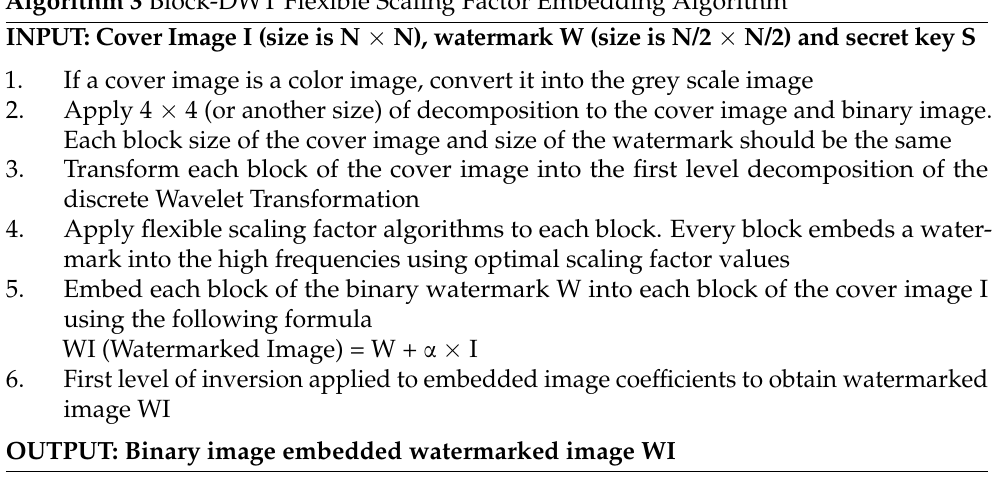
Algorithm 3 Block-DWT Flexible Scaling Factor Embedding